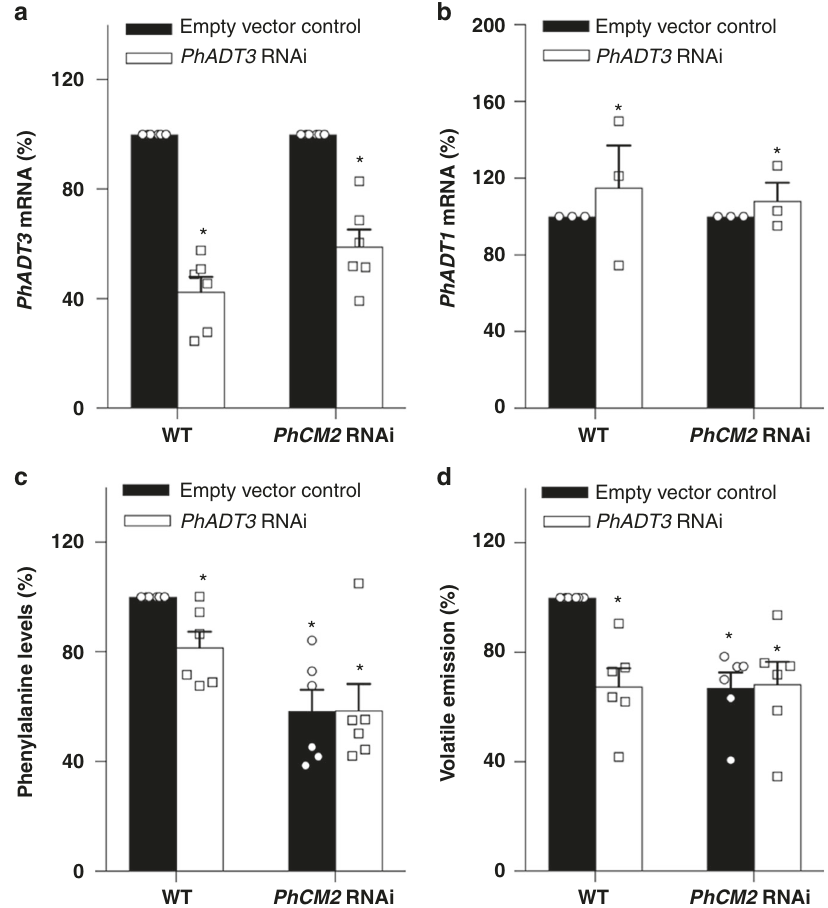
Fig. 6 Effect of PhADT3 RNAi downregulation in wild-type and PhCM2 RNAi petunia fl owers. a , b PhADT3 mRNA ( a ) and PhADT1 mRNA ( b ) levels in wild- type and PhCM2 RNAi line 15 petunia fl owers. For each genetic background, black and white bars represent fl owers in fi ltrated with empty vector or the PhADT3 RNAi construct, respectively. Data are presented as a percentage relative to the corresponding empty vector reference. c , d Levels of phenylalanine ( c ) and phenylalanine-derived volatiles ( d ) in petunia fl owers of wild-type and PhCM2 RNAi line 15 in fi ltrated with agrobacterium carrying the empty vector (black bars) or the PhADT3 RNAi construct (white bars). For ( c , d ) data are presented as a percentage relative to the WT empty vector reference. Data are means ± SE ( n = 6 biological replicates). * P < 0.01 as determined by paired two-tailed Student ’ s t